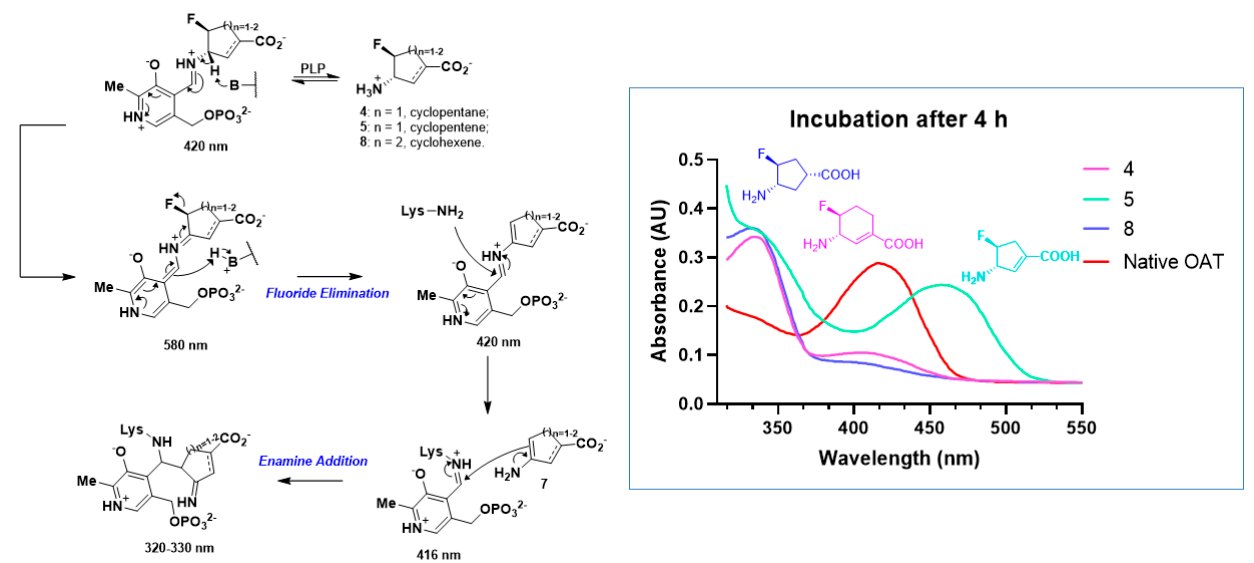
Figure 4. Wavelength absorbance measurement for 4 , 5 , and 8 after 4 h incubation with h OAT.